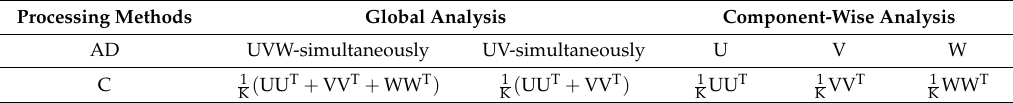
Table 2. Five spatial correlation matrices for different decomposition dimensionalities. Processing